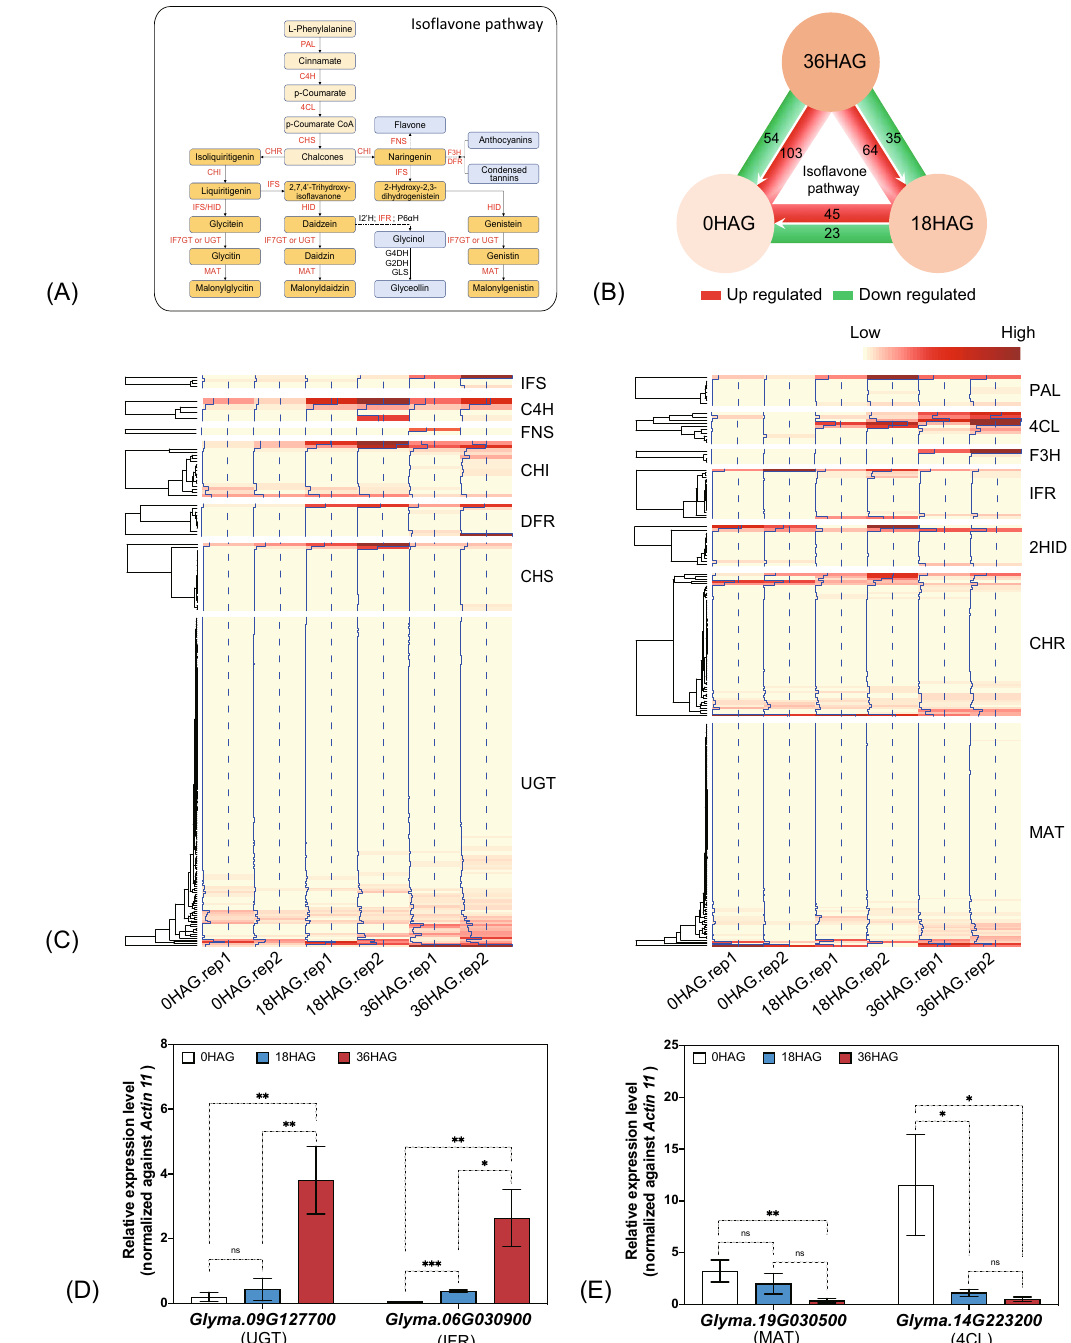
Figure 6. Expression pattern of genes involved in isoflavone metabolism. ( A ) Isoflavone pathway (details could be found in the Introduction section); ( B ) up and down regulated gene number between different germination time points (18HAG v.s. 0HAG, 36HAG v.s. 18HAG, 36HAG v.s. 0HAG); ( C ) Heatmap of coding genes expression pattern for IFS (isoflavone synthase), C4H (cinnamate 4-hydroxylase), FNS (flavone synthase), CHI (chalcone isomerase), DFR (dihydroflavonol 4-reductase), CHS (chalcone synthase), IF7GT/UGT (isoflavone 7-O-glucosyltransferase), PAL (phenylalanine ammonia-lyase), 4CL (4-coumarate-CoA ligase), F3H (flavanone 3-hydroxylase), 2HID (2-hydroxyisoflavanone dehydratase), CHR (chalcone reductase), MAT (isoflavone 7-O-glucoside 6"-O-malonyltransferase), IFR (isoflavone reductase); ( D , E ) qRT-PCR confirmation of representative genes UGT: Glyma.09G127700 ; IFR: Glyma.06G030900 ; MAT: Glyma.19G030500 ; 4CL: Glyma.14G223200 ) in isoflavone metabolic pathway. Relative expression level of each gene was normalized against Actin 11 . *, **, ** indicates significant level of P < 0.05, 0.01, and 0.001 respectively by Student’s t -test, ns denotes none significant. Dashed line represents several